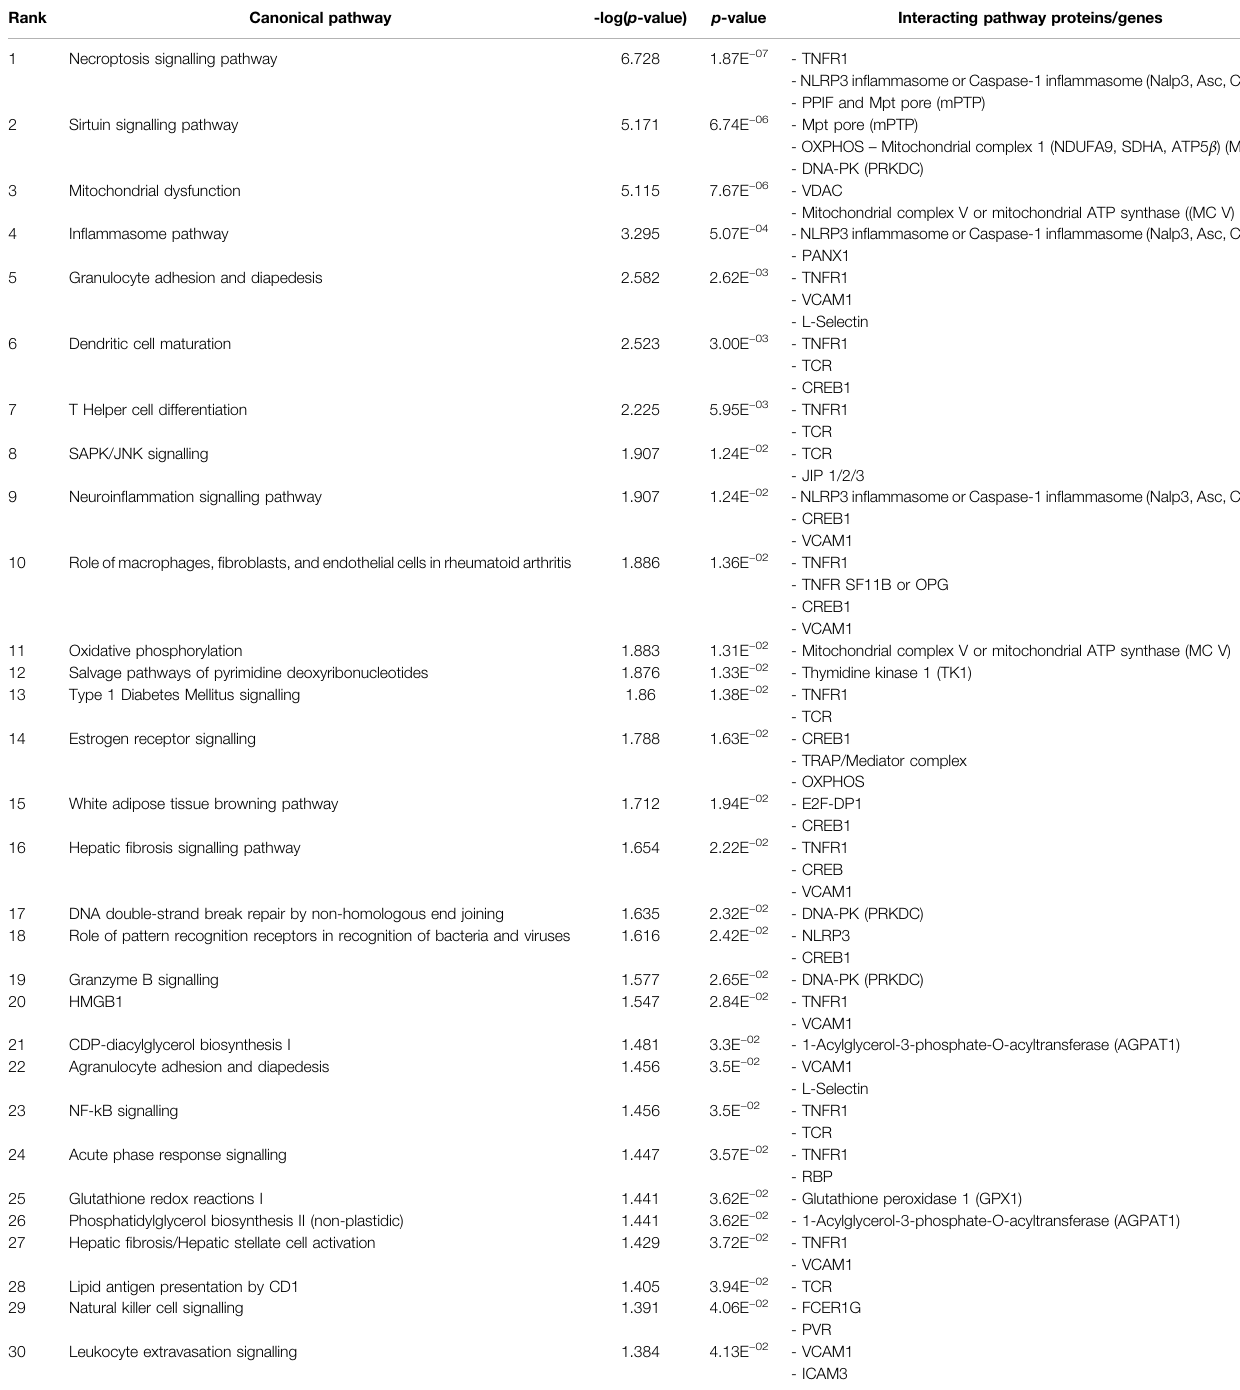
TABLE 1 | Canonical pathways of TSPOAP1 predicted by Ingenuity Pathway Analysis, highlighting the interacting protein or gene partners in the signalling pathways.